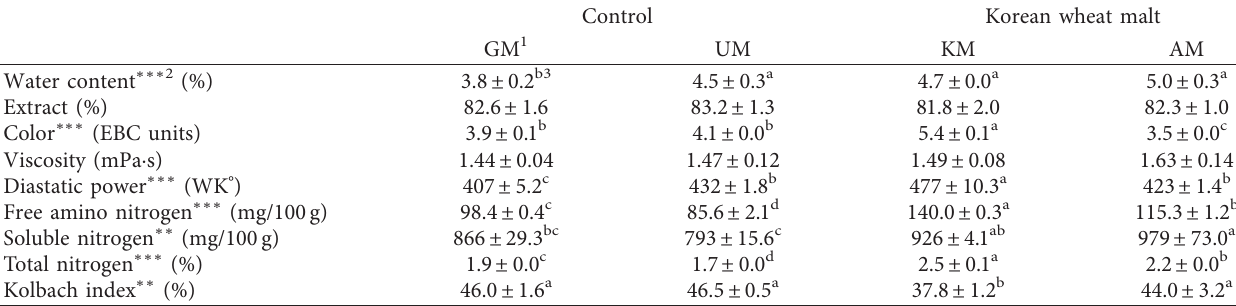
Table 1: Wheat malt quality parameters.